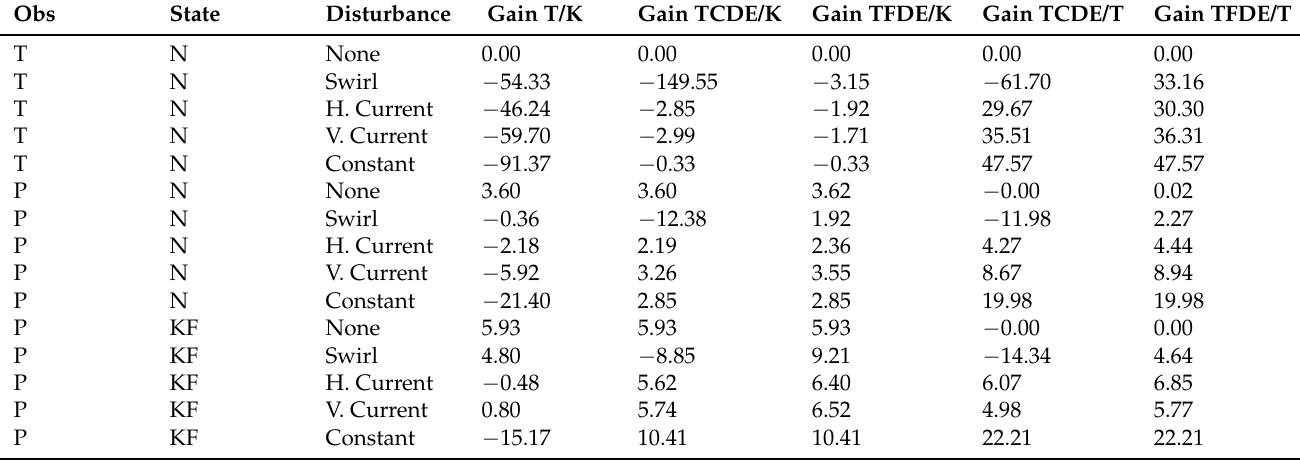
Table 3. Total cost results, where observation is total (T) or partial (P), and the state estimator used is none (N) or a Kalman filter (KF). The cases tested are full knowledge of the model (K), transition estimator without disturbance estimator (T), transition estimator and CDE (TCDE), and transition estimator and FDE (TFDE). In all cases, higher means that the first model is better, and results can be interpreted as percentages. Note that the gains of using both disturbances estimators are significant compared to only using the transition estimator, and may obtain similar results to actually knowing the